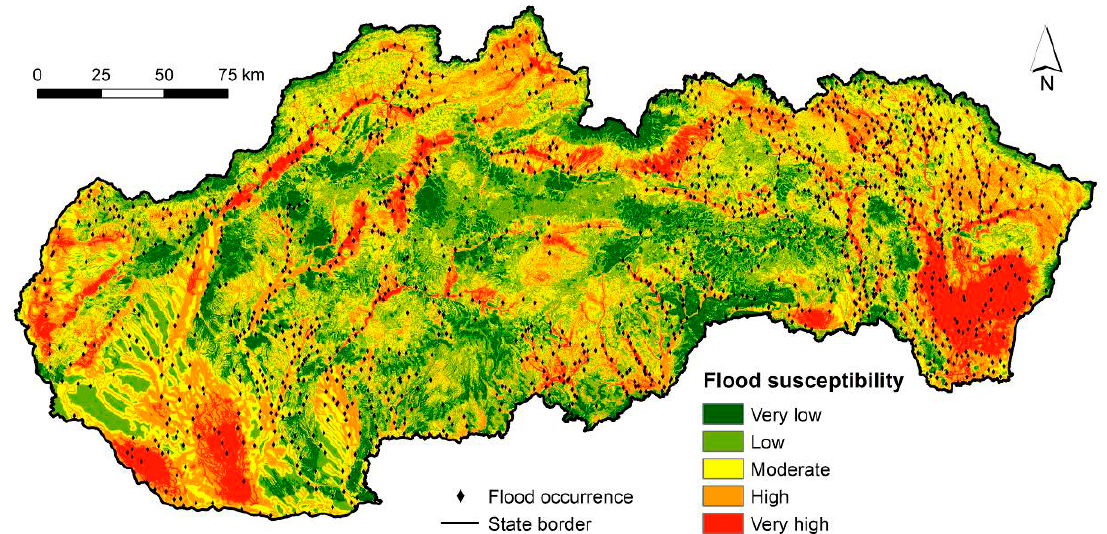
Figure 6. Flood susceptibility and flood historical points. Table 5. Area coverage of flood susceptibility classes and share of flood events corresponding to the defined flood susceptibility classes.